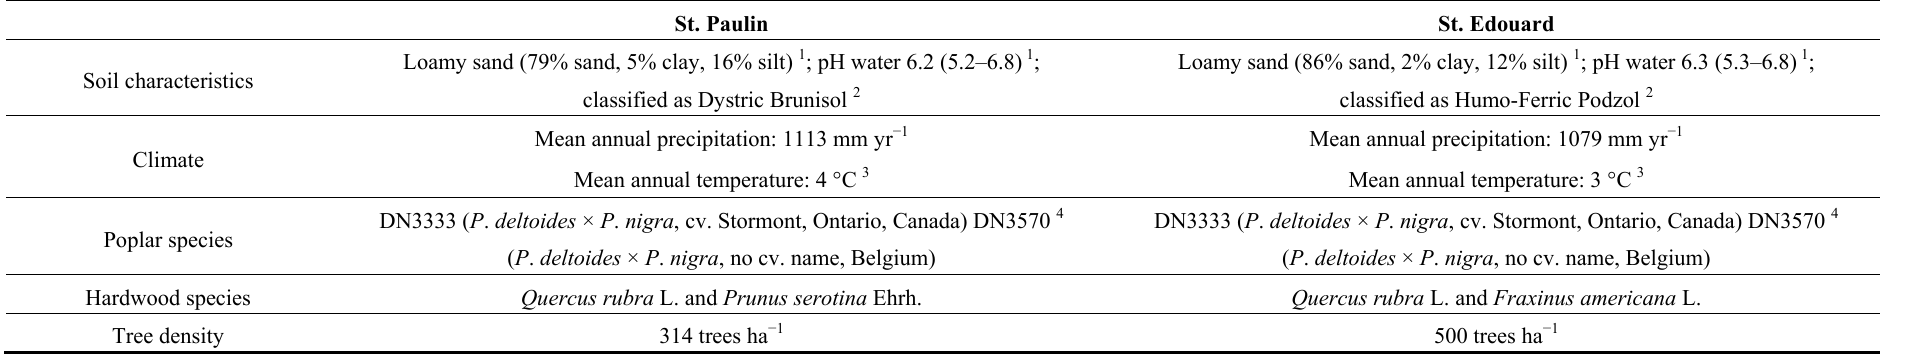
Table 1. Characteristics of the experimental tree-based intercropping systems at St. Paulin and St. Edouard, southern Quebec, Canada.